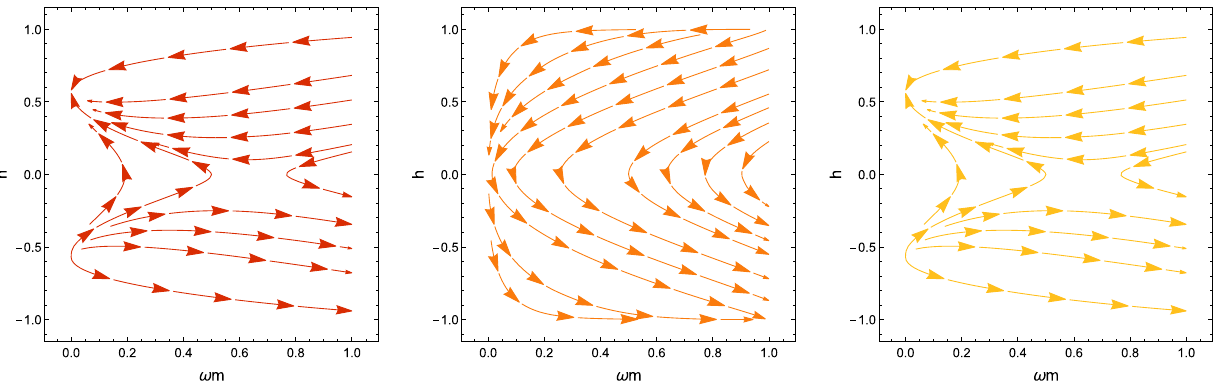
Fig. 2 Phase-space diagram for the dynamical system (31)–(35) in the ω m − h surface and for three different values of β , γ = 4 by the point P 1 The middle figure is for β = 0, the left figure for β < 0 and the right figure for β >